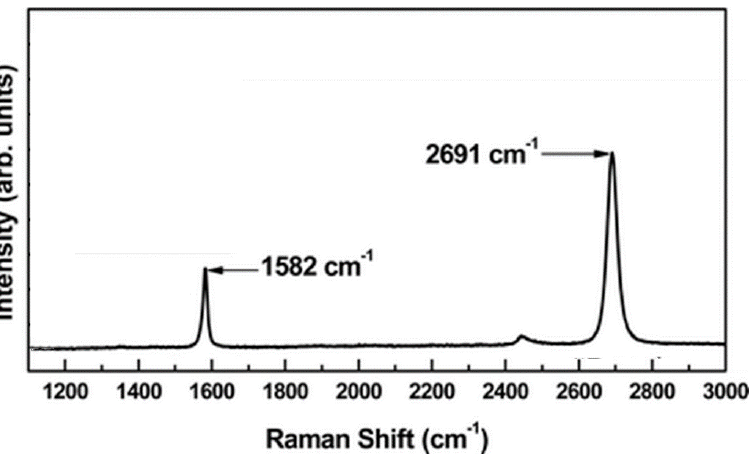
Figure 4. Raman spectra of single layer highly pure graphene as reported by Calizo et al. [94] Re- printed with all permissions from American Chemical Society (Copyright © 2007 American Chem- ical